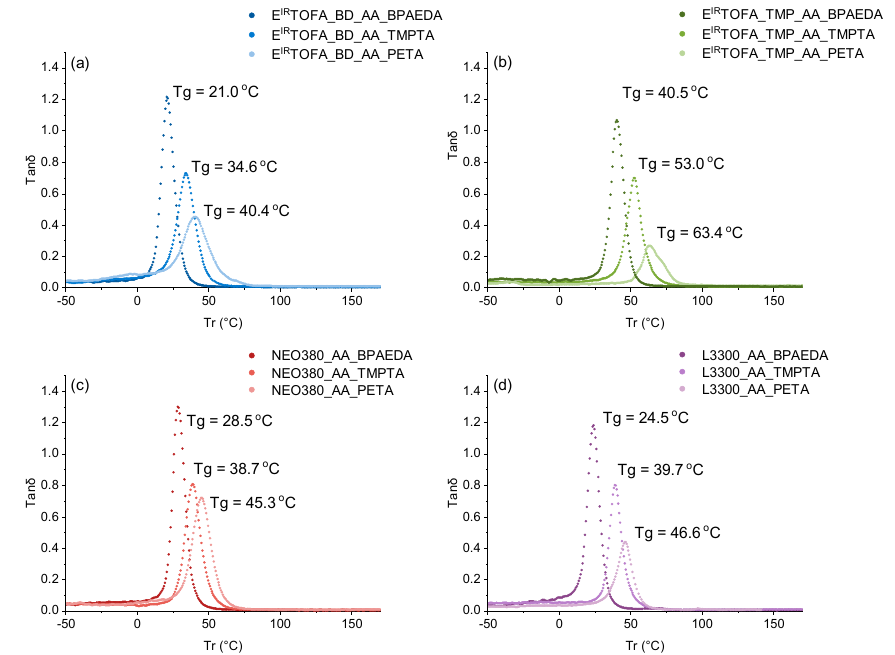
Figure 6. Tan δ curves of polymer monoliths from synthesized acetoacetates and BPAEDA, TMPTA, and PETA acrylates. ( a ) Polymers from E IR TOFA_BD_AA; ( b ) polymers from E IR TOFA_TMP_AA; The glass transition temperatures determined by the DMA method are summarized in Table 2. Glass transition temperatures (T g ), cross ‐ link density ( ν e ) and molecular weight between cross ‐ links (M c ) from DMA tests and density ( ρ ) of polymer monoliths from tall oil polyol or com ‐ mercial polyol ‐ based acetoacetates and BPAEDA, TMPTA, and PETA acrylate. Sample